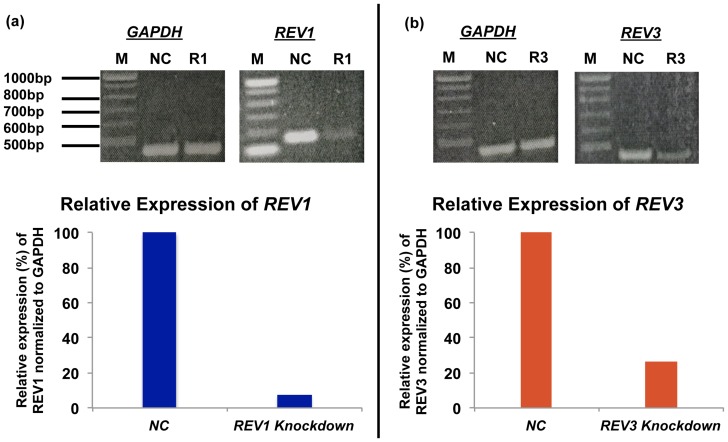
Representative gel images of siRNA knockdown of TLS pols in HEK293T cells.RT-PCR shows the efficiency of inhibition of the TLS pols. M, the DNA size marker; NC, negative control siRNA. Panel (a) shows the RT-PCR of Rev1 as R1; Panel (b) shows the same for Rev3, the catalytic subunit of pol ζ (R3). In each case, as a negative control of RT-PCR, the effects of siRNA were also inspected on glyceraldehyde-3-phosphate dehydrogenase (GAPDH) mRNA expression. The mRNA expressions of Rev1 and Rev3 of pol ζ relative to negative control (NC) are shown in the bar graph on the bottom.